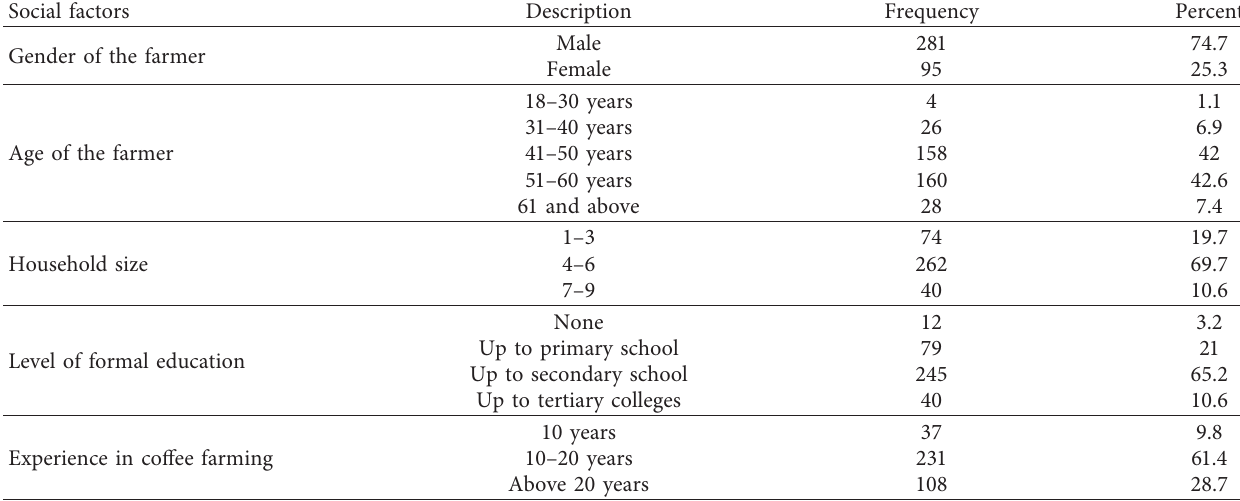
Table 1: Frequencies of key social characteristics of the respondents.